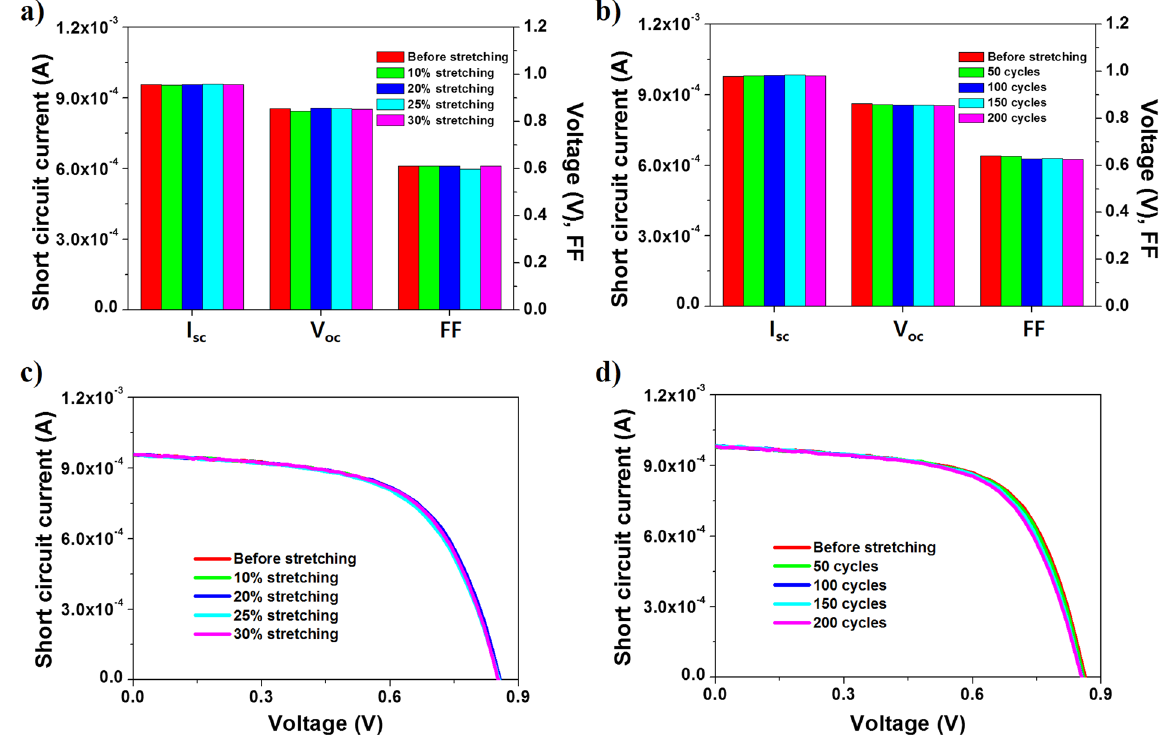
Figure 5. Photovoltaic characteristics of single buckled ribbon as a function of ( a ) tensile strain and ( b ) stretching cycle. Current-voltage curves of single buckled ribbon as a function of ( c ) tensile strain and ( d ) stretching